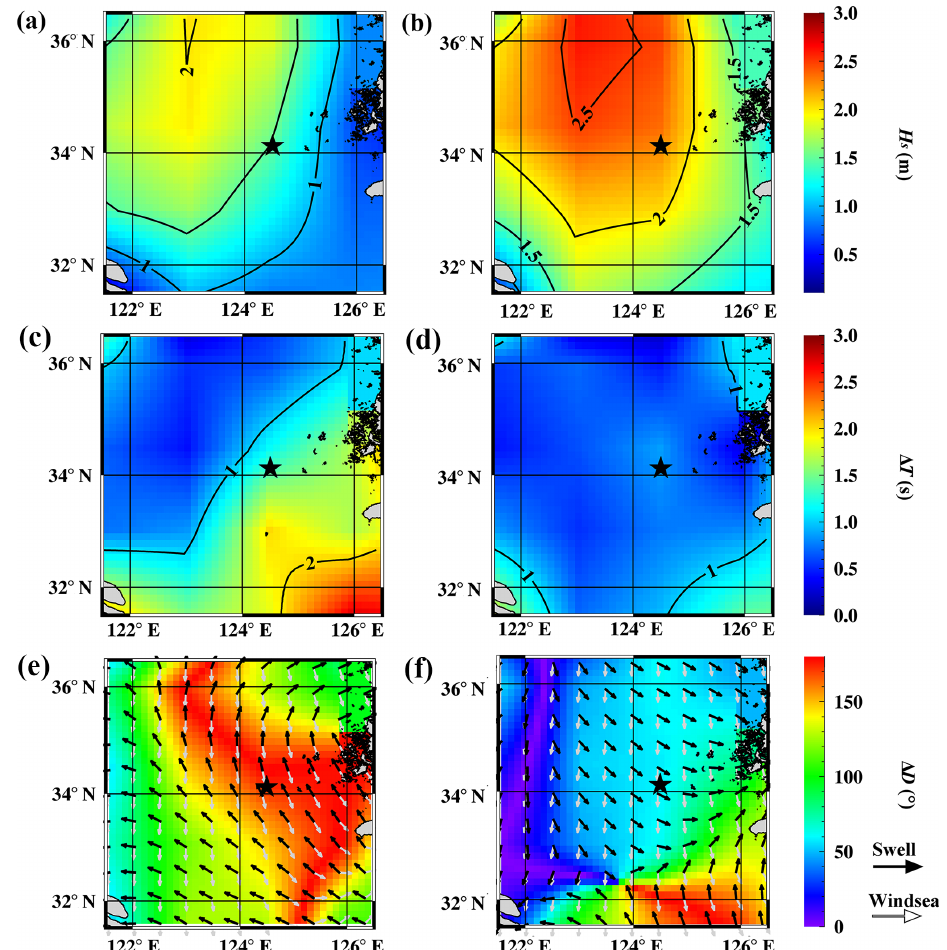
Figure 5. The sea state in the vicinity of the case that occurred on 24 February 2009. Panels (a) , (c) , (e) and (b) , (d) , (f) are the model results at 18:00 and 21:00UTC, respectively; panels (a) and (b) are H s , (c) and (d) are (cid:49)T and (e) and (f) are (cid:49) D. The accident location is marked with a black star. Arrows in the plots of the third row represent the wave directions of the swell (black) and wind sea (light grey).